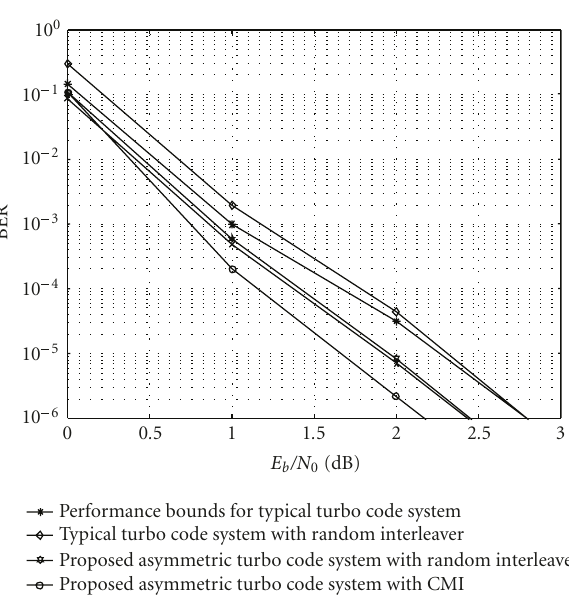
Figure 8: Performance bound and simulation results for typical and proposed asymmetric turbo code systems over AWGN channel, N = 400, r = 1 /